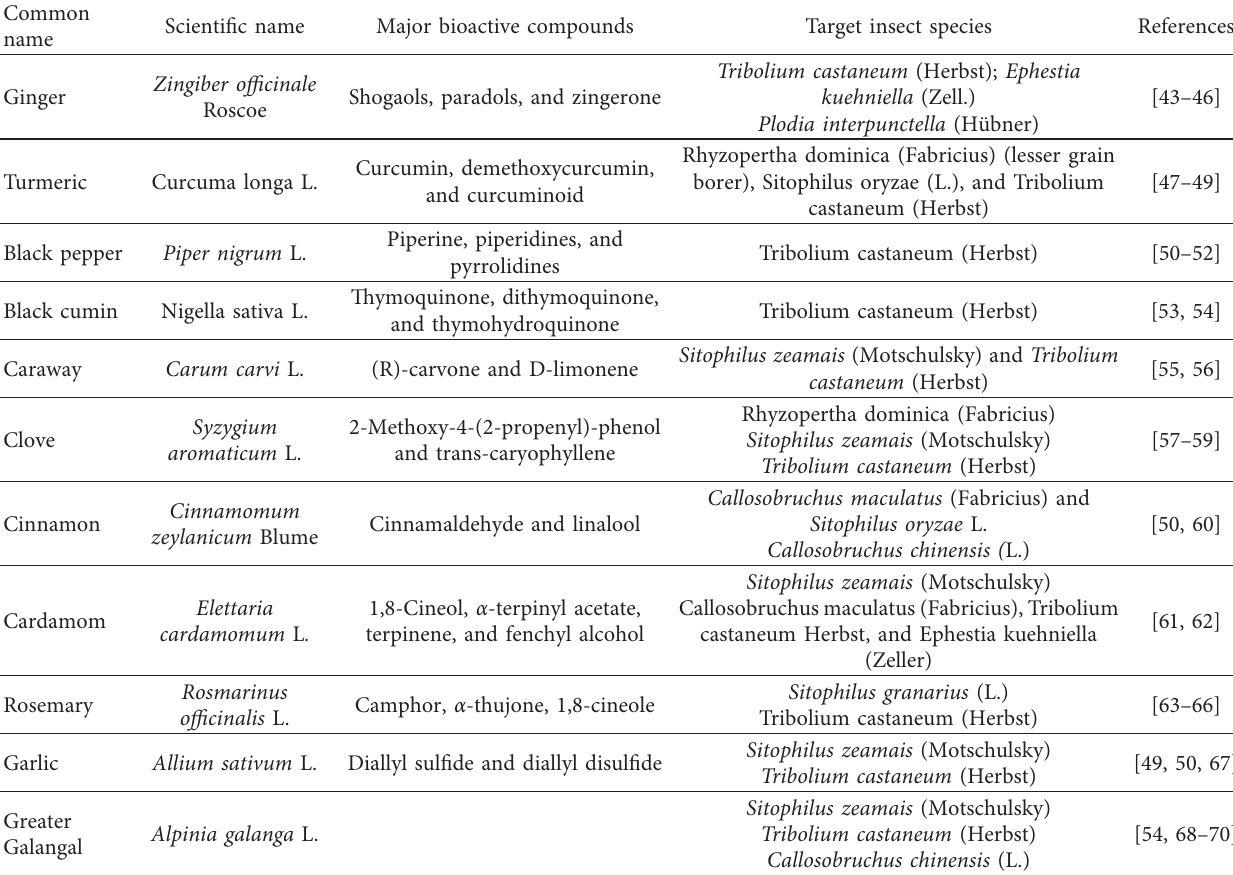
Table 2: Common spices used in the management of stored grain insect